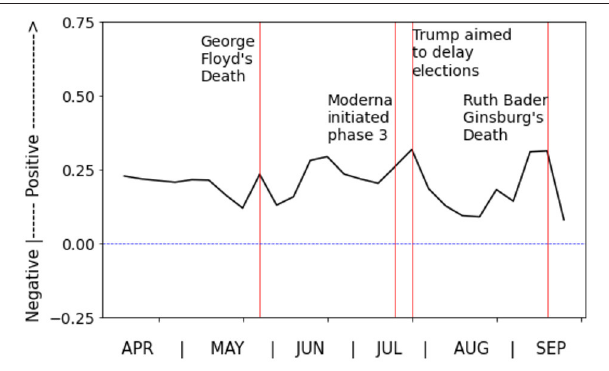
FIGURE 2 | Weekly average of sentiments in responses over time. A sentiment score of − 1 represents very negative and + 1 very positive.